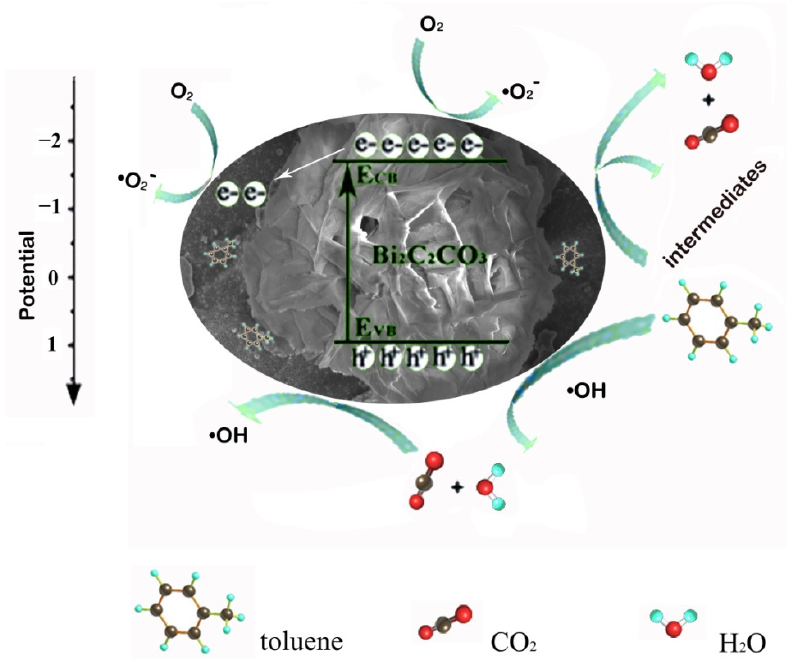
Figure 9. Photocatalytic mechanism of toluene removal using BOC/AC